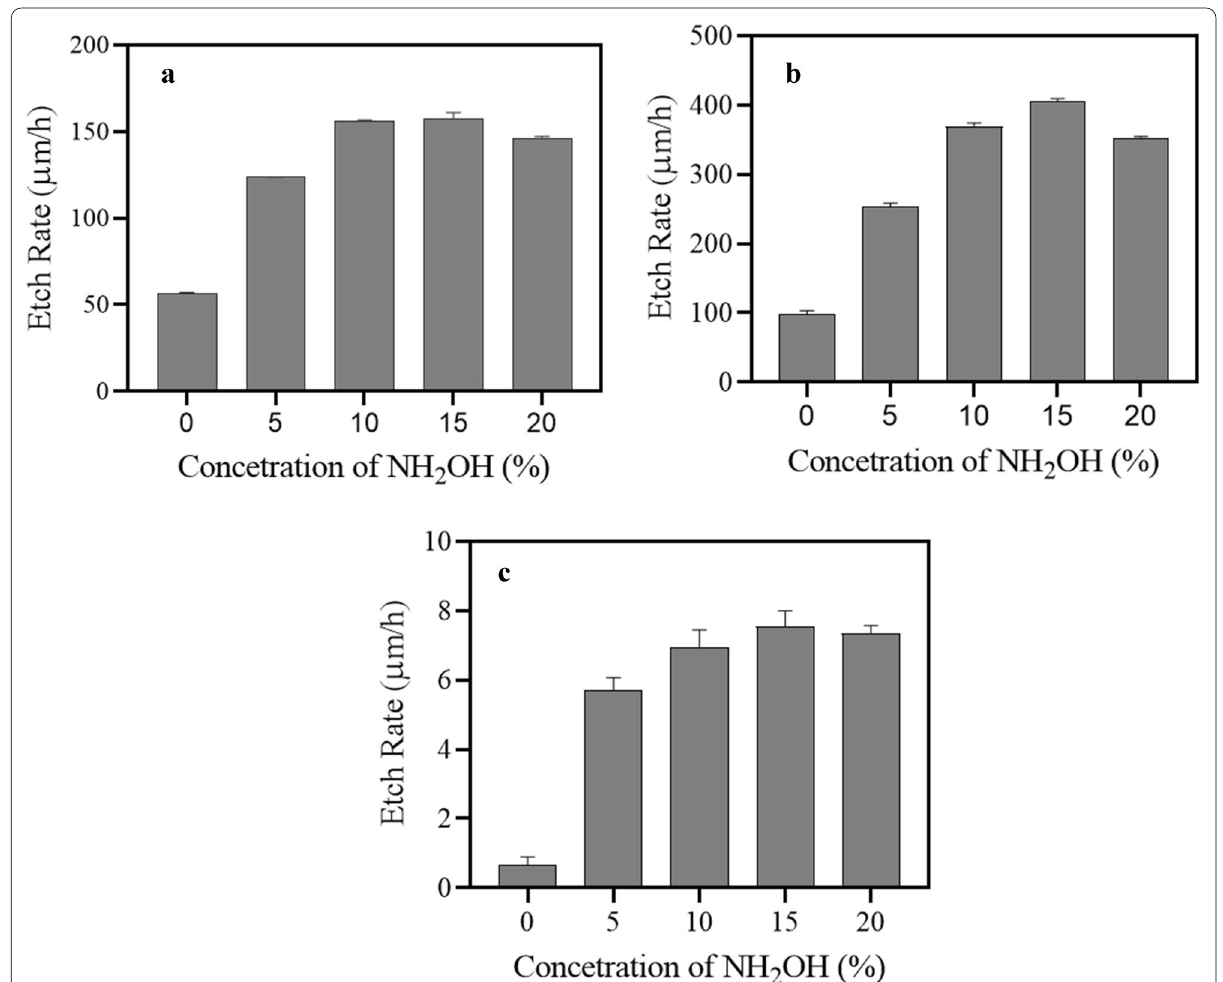
Fig. 29 Etch rate of a Si{100} b Si{110} and c Si{111} in 20 wt% KOH without and with varying concentrations of NH 2 OH at 75